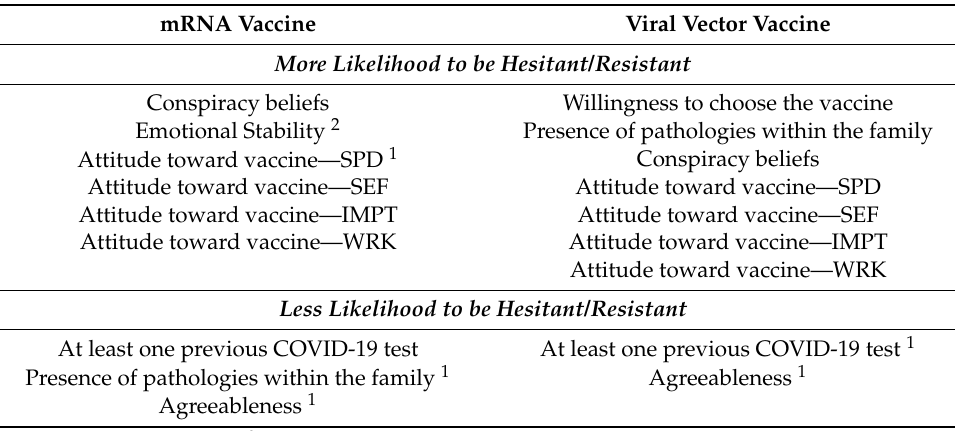
Table 3. Factors associated with mRNA and viral vector vaccines hesitancy. mRNA Vaccine Viral Vector